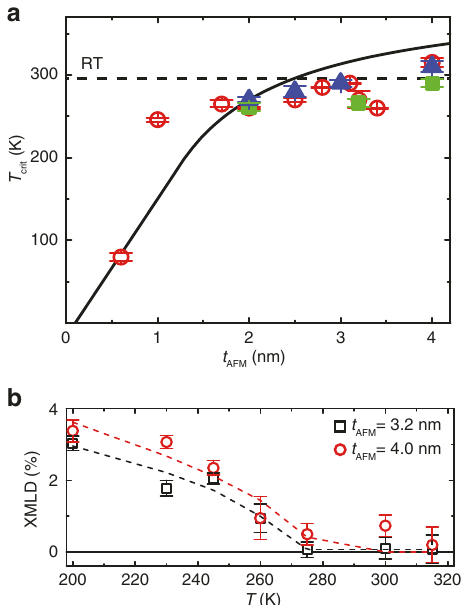
Fig. 4 The critical temperatures T crit as a function of the IrMn layer thickness t AFM . a Theoretical prediction according to ref. 25 (black line), data from Seebeck measurements (Supplementary Note 7 and Supplementary Fig. 6) (red circles), susceptibility data (Supplementary Note 10 and Supplementary Fig. 9) (blue triangles), XMLD data (green squares). b Temperature dependence of the XMLD signals on the sample with t AFM = 3.2 nm (black open squares) and the sample with t AFM = 4.0nm (red circles) determined by twice-integrating the XMLD signal under the L 3 peak. The error bars are generated from the standard deviation of the integrated signal. The solid line is a fi t to a generic power-law